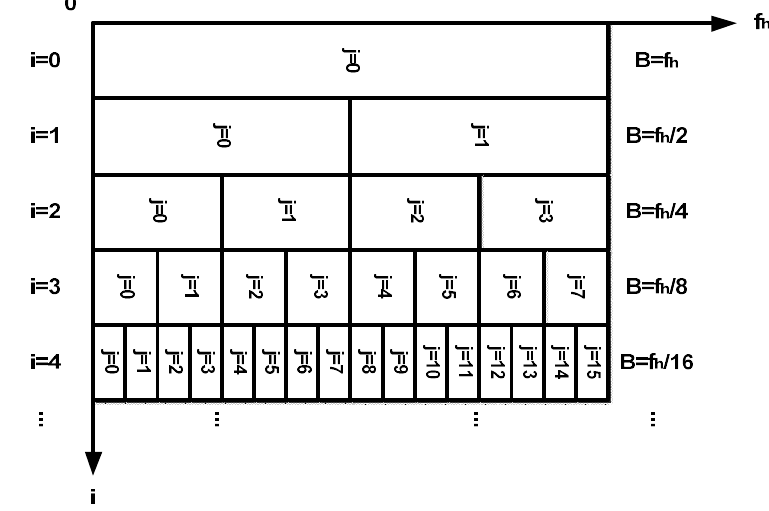
Figure 2. Frequency domain distribution map of wavelet packet transformation (WPT).